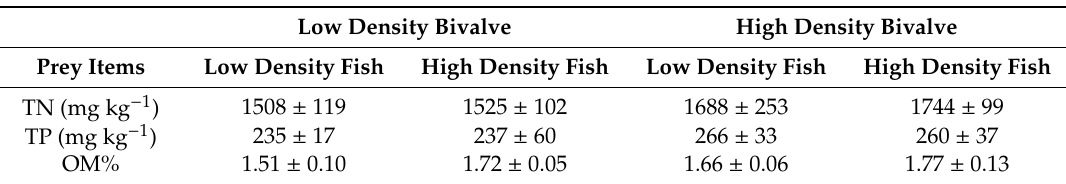
Table 4. The content of total nitrogen (TN), total phosphorus (TP) and organic matter (OM) in the di ff erent treatments at the end of experiment (Means ±